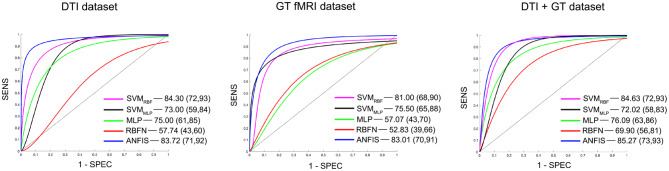
Details of the ROC curves and relative AUC (95% IC) values obtained from each run classifier (SVMRBF, SVMMLP, MLP, RBFN, and ANFIS) using input data from the DTI data set (on the left), the GT fMRI data set (in the middle), and the DTI + GT data set (on the right).